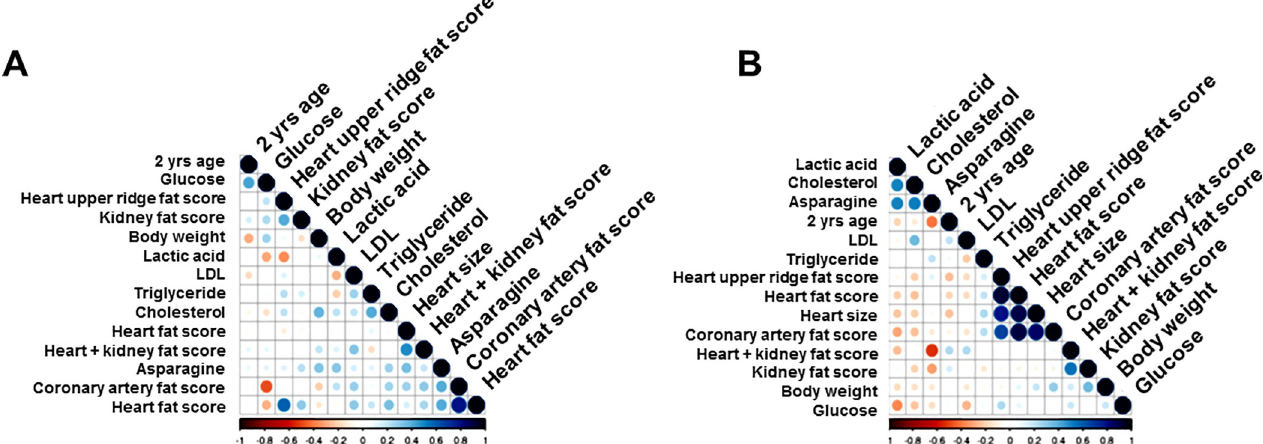
Fig 5. Correlation between fat scores, clinical measures, and selected metabolites in (a) female (n = 26) and (B) male (n = 34) baboons. Correlations are in a scale of +1 (positive, blue) to -1 (negative, red).